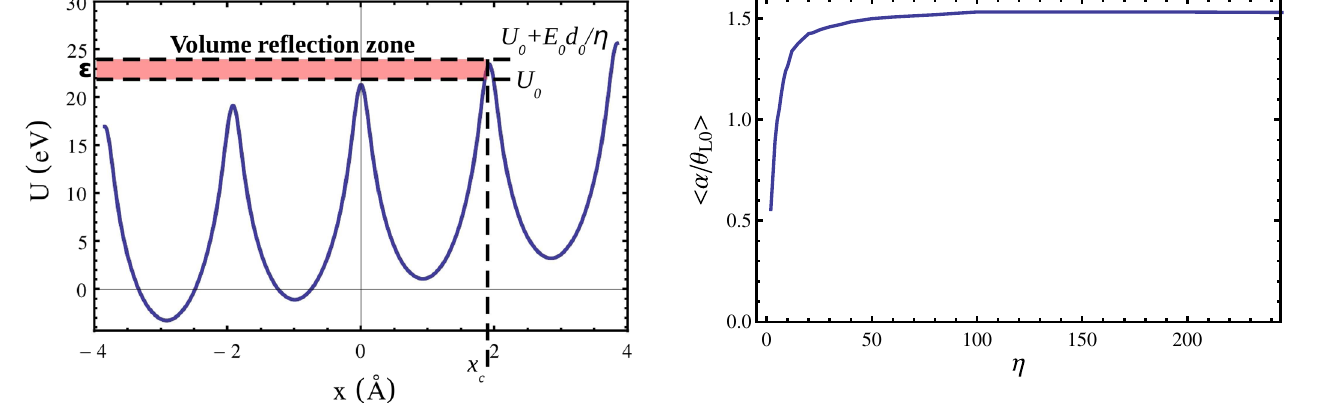
FIG. 2. Interplanar potential in (110) Si crystal.